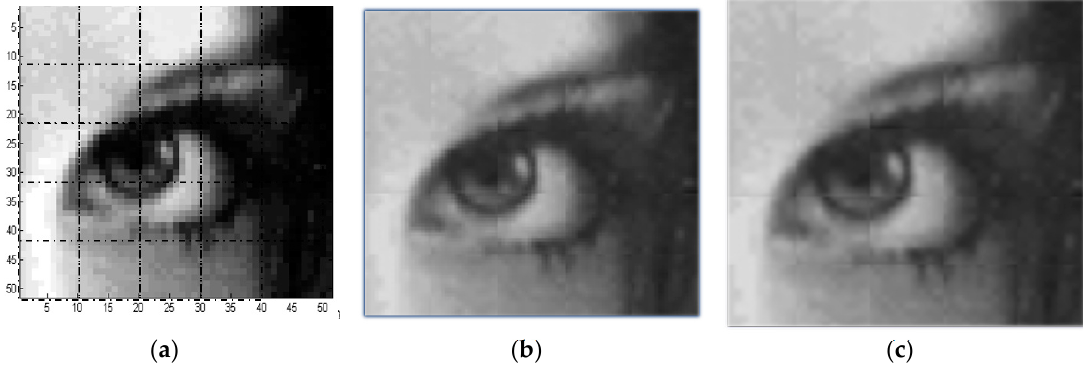
Figure 14. Reconstruction by using local TPS method: ( a ) A 50 × 50 Pixel 2 image is divided into 25 square windows; ( b ) Reconstructed image at resolution of 100 × 100 Pixel 2 ; ( c ) Reconstructed image at resolution of 250 × 250 Pixel 2 .